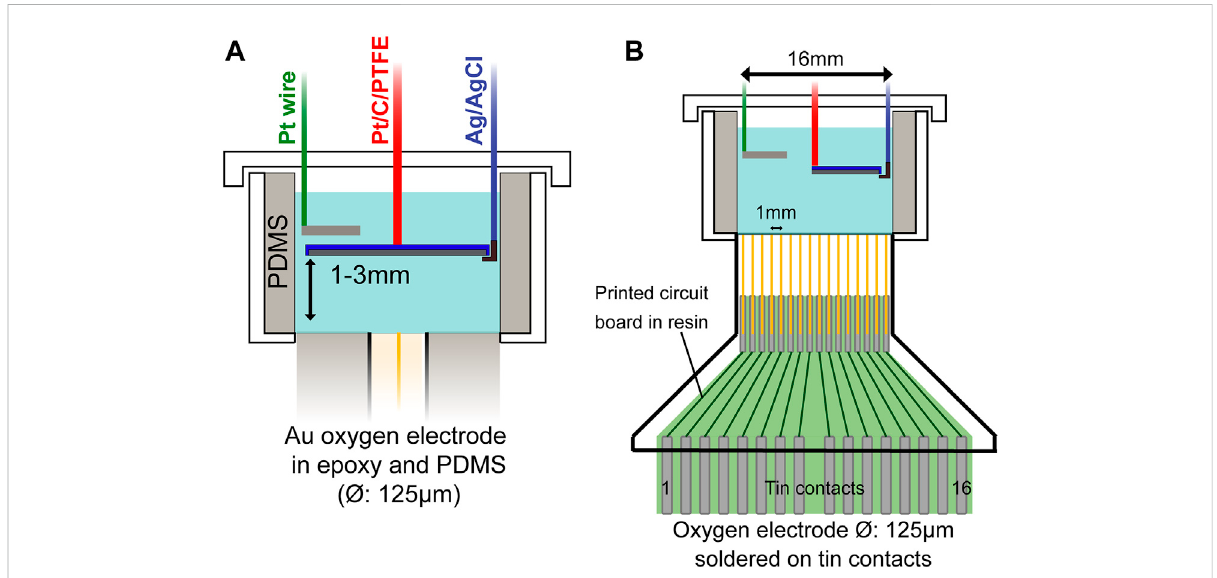
FIGURE 1 Schematic diagram of eLOSS set-up with Pt/C scavenging electrode and with Clark-like O 2 measuring electrode(s) in base. (A) Scavenging electrode covering entire cell and (B) a ‘ half ’ electrode giving an oxygen gradient across the culture compartment for in vitro cell